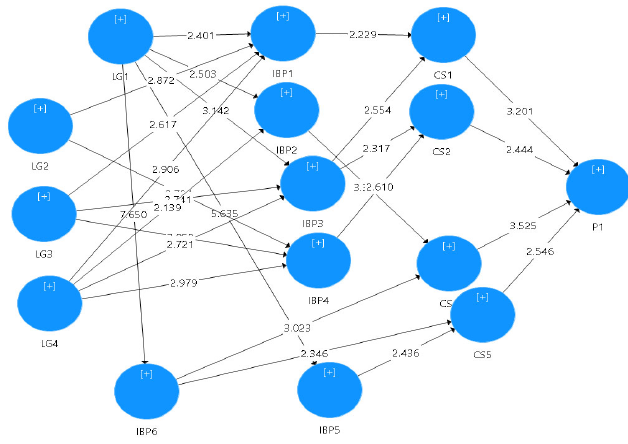
Fig. 4. Final Results of Model 1 Testing